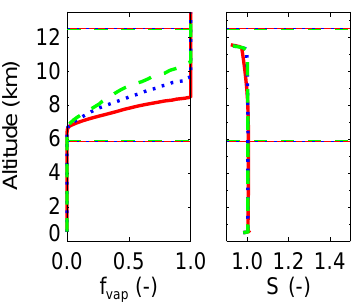
Figure 8. Terminal fall speeds for ice particles as a function of area- equivalent diameter at temperature − 20 ◦ C and pressure 350hPa for fluffy ice treated first as spheres (baseline treatment; red solid line), second as with the same mass-dimensional relation but as oblate spheroids (blue dotted line), and third as plates with a dif- ferent mass-dimensional relationship (green dashed line), and for dense ice (dash-dotted magenta line, see Sect. 4.7). Filled area de- notes predominant size range of ice mass in Airbus measurements. Details provided in